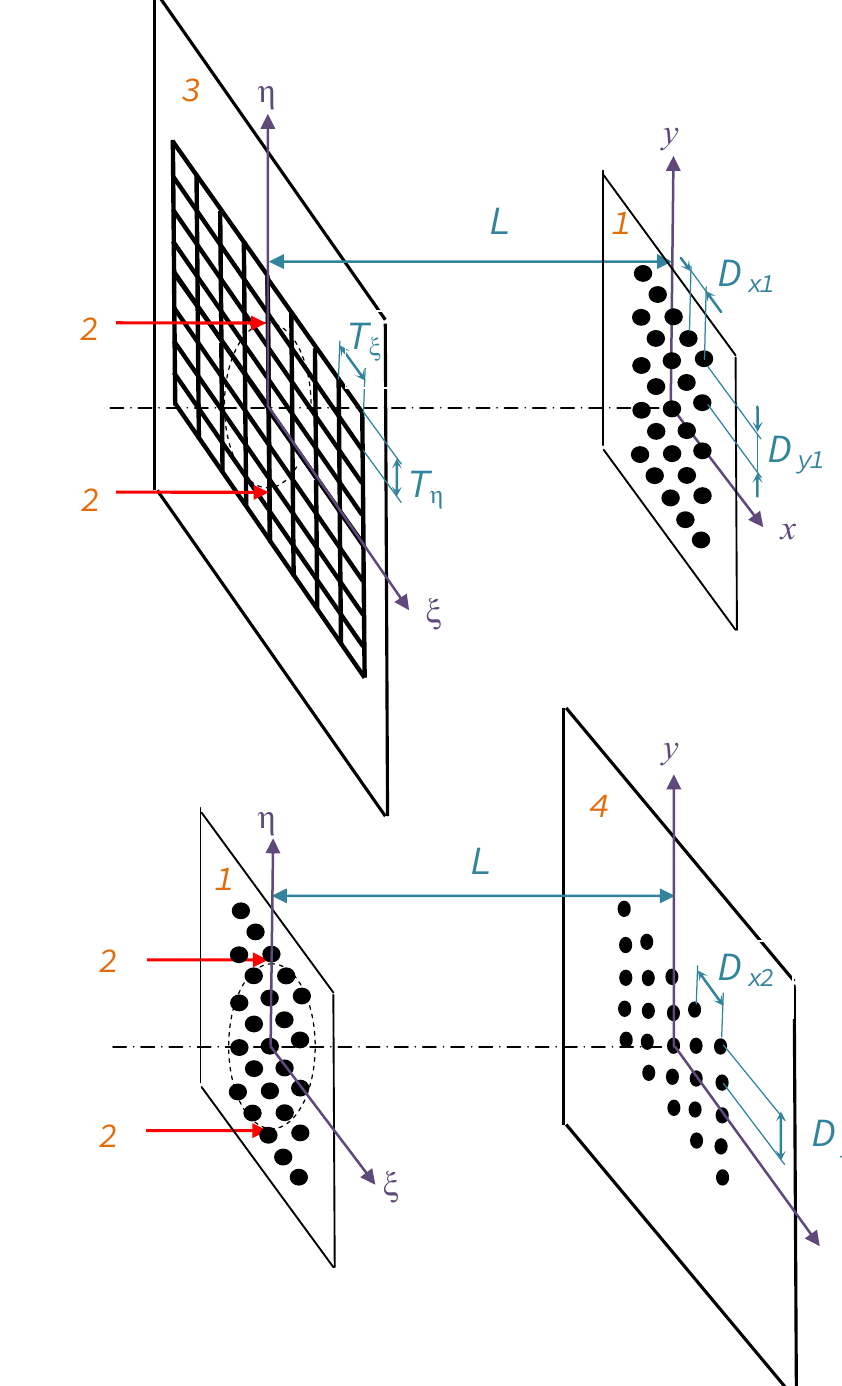
Figure 1. ( a ) Achieving the diffraction pattern of the source material; ( b ) Achieving the diffraction pattern of the diffraction pattern image from ( a